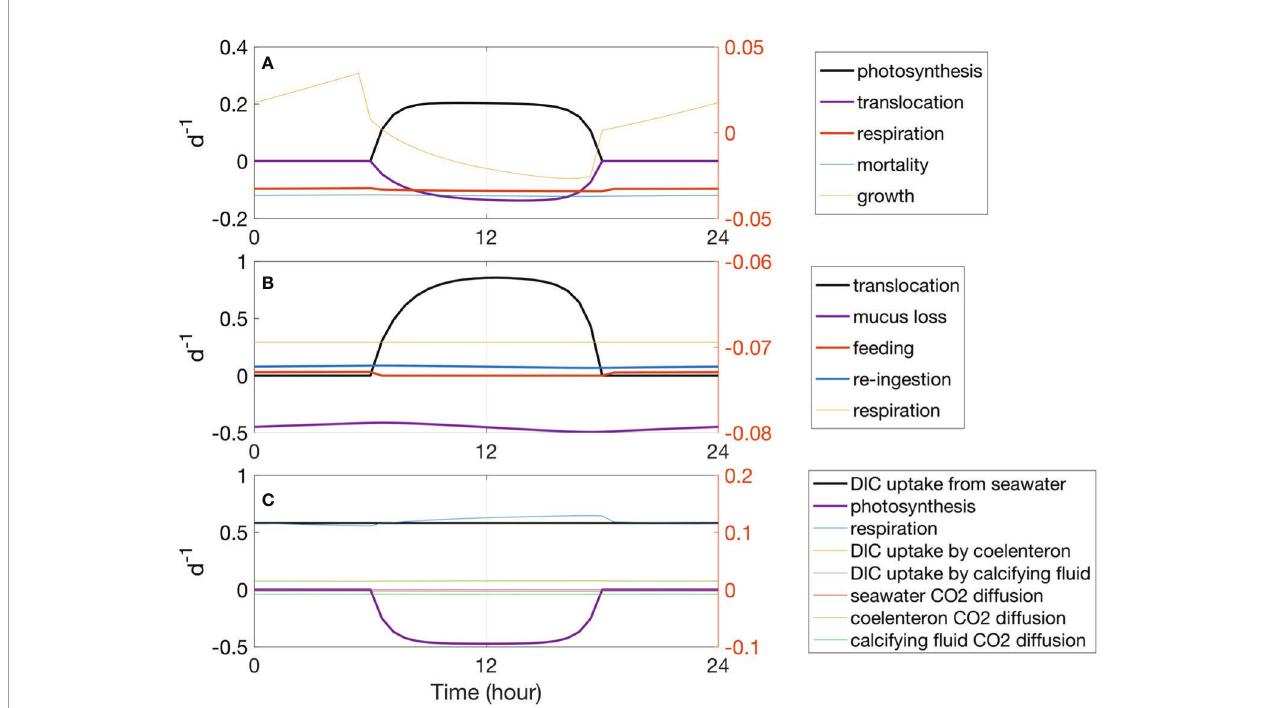
FIGURE 5 | Fluxes in fl uence carbon change in the symbiotic association as per the model simulation: (A) symbiont cellular carbon fl uxes, (B) host carbon fl uxes, and (C) host tissue DIC fl uxes. As different processes experience different magnitudes of change, the major processes were plotted as bold lines with the corresponding values shown on the left axis to illustrate daily coral carbon variability. The minor processes were scaled on the right axis to demonstrate the diurnal cycle of these fl uxes. Positive values indicate carbon input, negative values indicate carbon